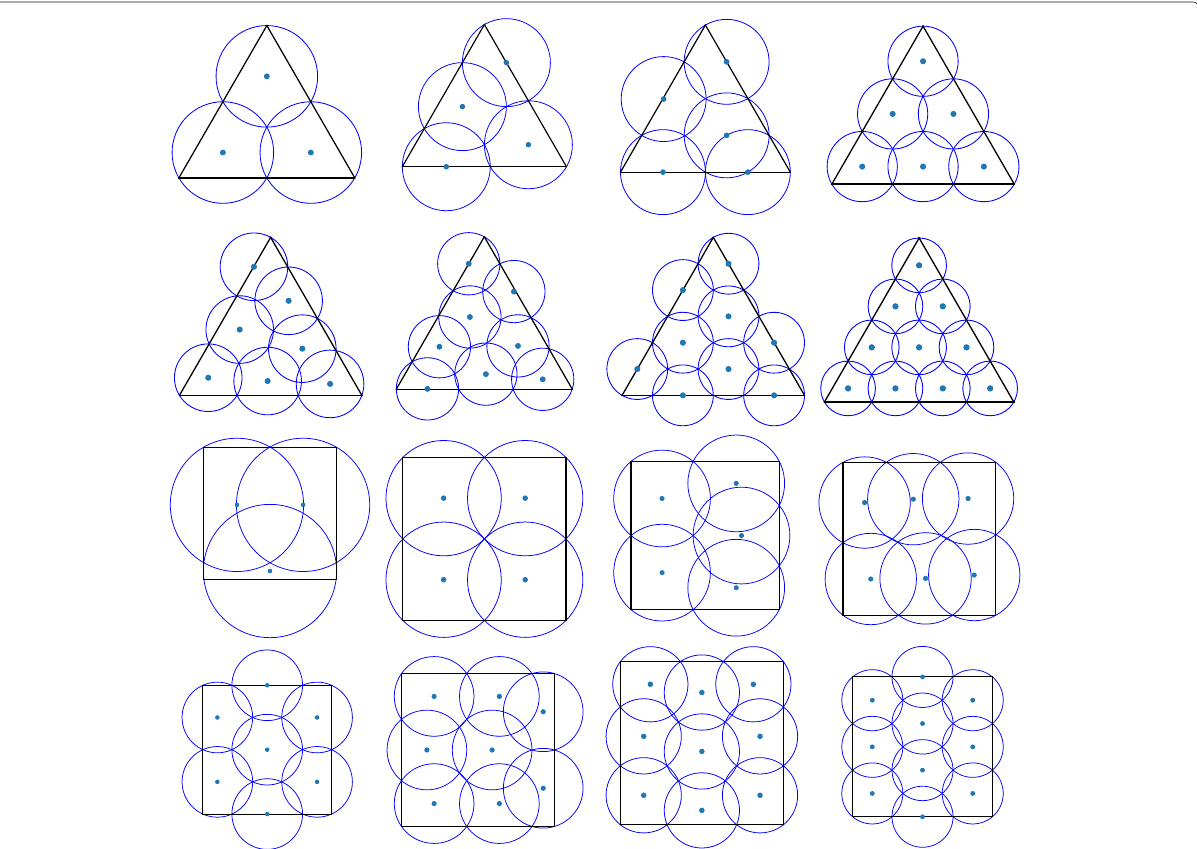
Fig. 8 Best solutions for regular triangular and square areas covered by 3 to 10 centers. The solution may not be unique due to the symmetry of the area